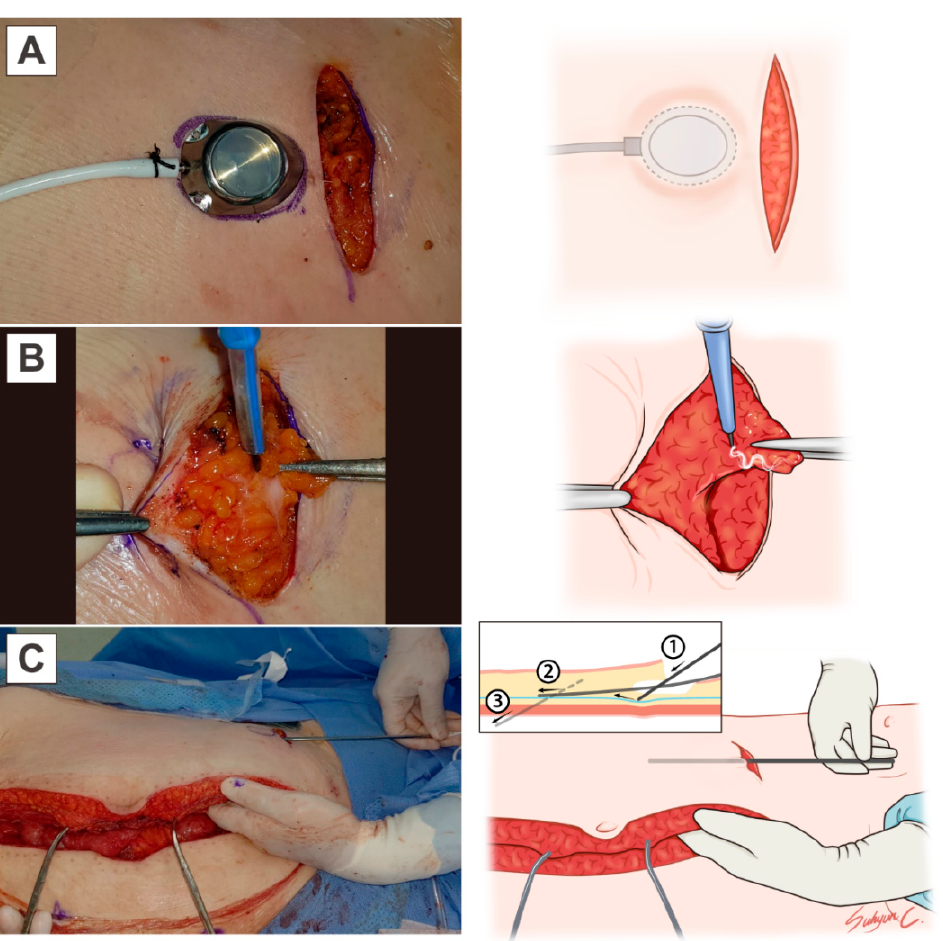
Figure 1. The modified IP catheter insertion technique: ( A ) A 5 cm length incision for the IP port was made at the mid-clavicular line on the lower rib, and the IP port chamber was outlined. ( B ) Subcutaneous tissue below the IP port chamber was partially removed for easy insertion of the needle into the IP port. ( C ) The catheter was inserted in a neutral position of the abdominal wall at the time of total closure of the wound. Retraction of the abdominal wall upward was avoided to prevent tortuous placement of the IP port line. While the guidewire was inserted into the fascia with the right hand, the left hand was used to palpate the optimal placement of the guidewire. The guidewire penetrated the fascia, muscle, and peritoneum subsequentially, while maintaining a natural position of the closed abdomen after passing 10–15 cm into the fascia.